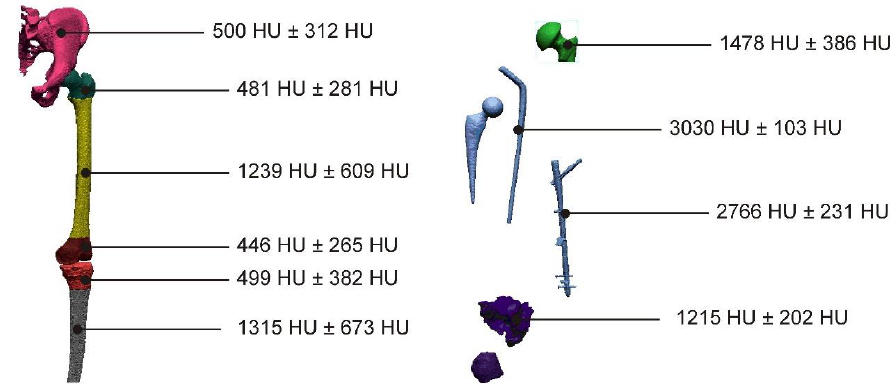
Figure 23. Obtained values (average value ± standard deviation) of the segmentation thresholds for anatomical structures, implants, and also the bone cement, within the areas of the hip joint and also the knee joint.